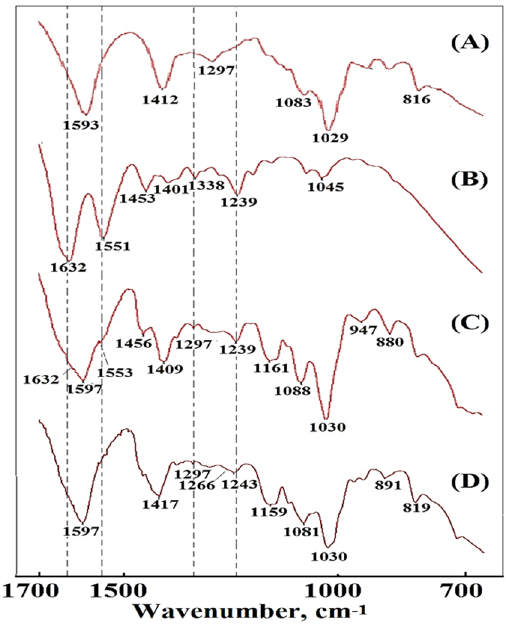
Figure 2. FTIR spectra of the samples in the 700–1700 cm − 1 region: ( A ) AG, ( B ) PCFM0N, ( C ) a composite foam material PCFM3N without ionic crosslinking reaction of CaCl 2(aq) , and ( D ) a cross-linked composite material PCFM3H with ionic crosslinking reaction of CaCl 2(aq) .